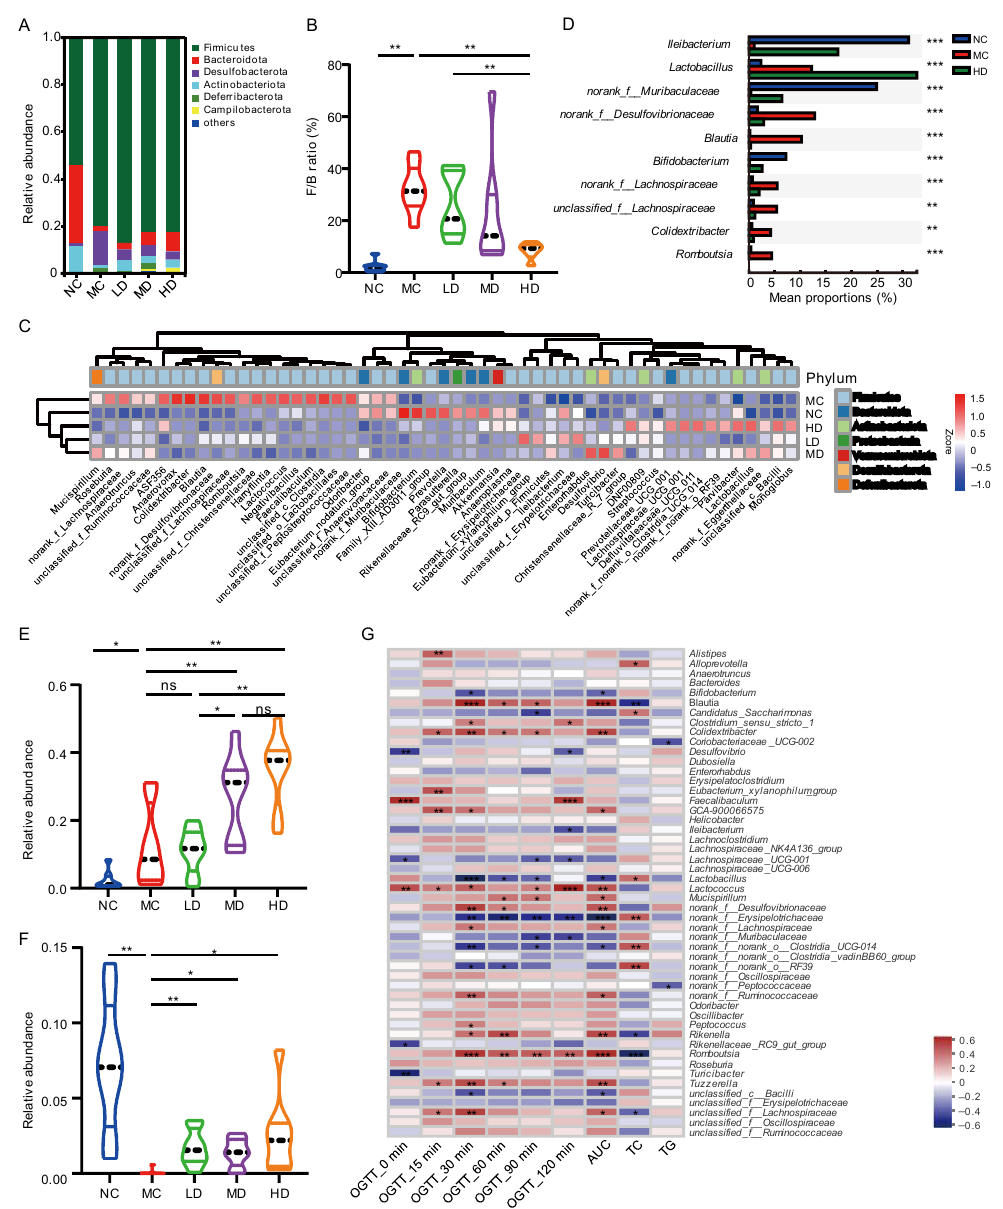
Figure 4. Effect of PHB on the composition of the fecal microbiome. ( A ) fecal microbial composition at the phylum level. ( B ) Bacteroidetes / Firmicutes ratio ( n = 6 of HD group). ( C ) Heatmap analysis at the genus level. ( D ) The top 10 species with the most significant differences in relative abundance at genus level between NC group, MC group, and HD group. (E-F) Relative abundance of Lactobacillus ( E ) and Bifidobacterium ( F ). ( G ) Heatmap of Spearman’s correlation analysis between fecal microbiota and glucose and lipid metabolism-related indexes. Significance was determined using Kruskal-Wallis H test, or Wilcoxon rank-sum test; * p <0.05, ** p <0.01, *** p <0.001 ( n = 8). OGTT_ t min, blood glucose level of mice at t min after oral administration of glucose after 12 weeks of intervention; AUC, the area under the curve of the 2-h oral glucose tolerance test at 12 weeks; TC, total cholesterol; TG, triglyceride.